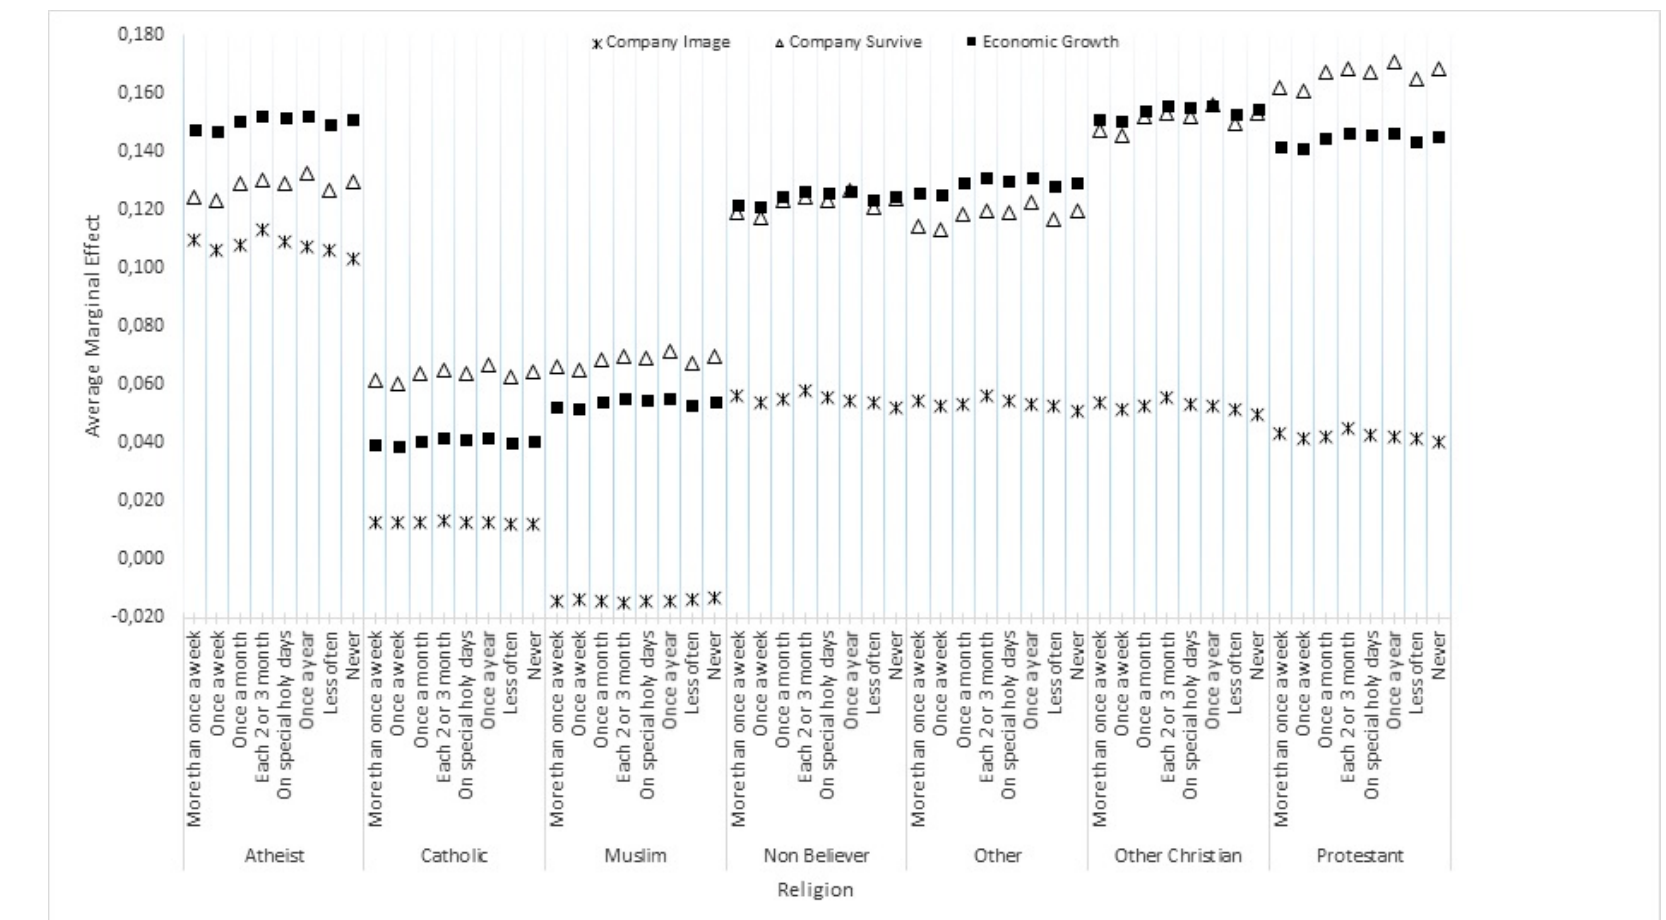
Figure 1. Logit marginal effects. Company image, company survival and economic growth vs. religion/religiosity.